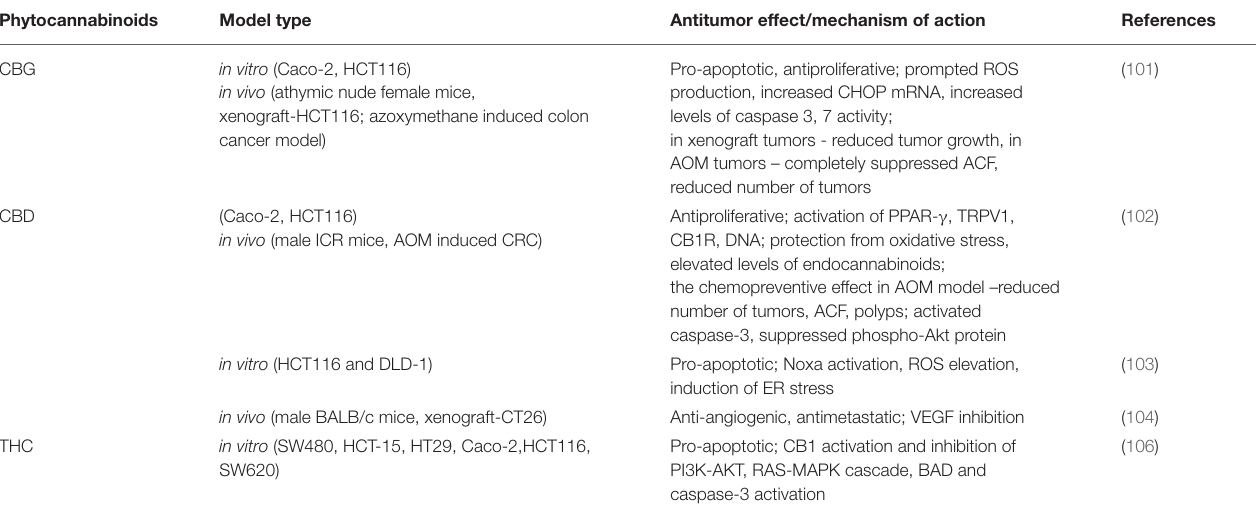
TABLE 4 | Cannabinoids anti-cancer potential in